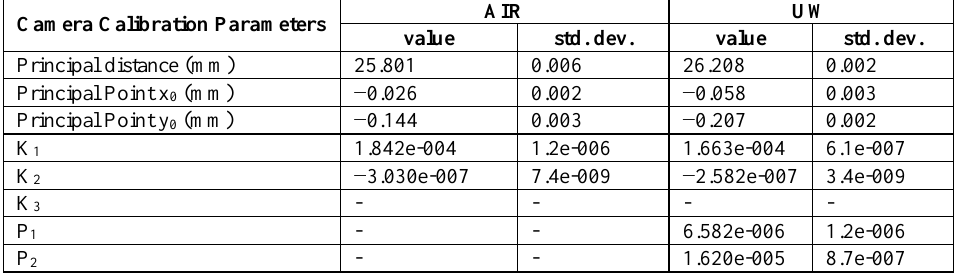
Table 3. Comparison between camera calibration in water (UW) and in air. Only statistically significant additional parameters are computed.